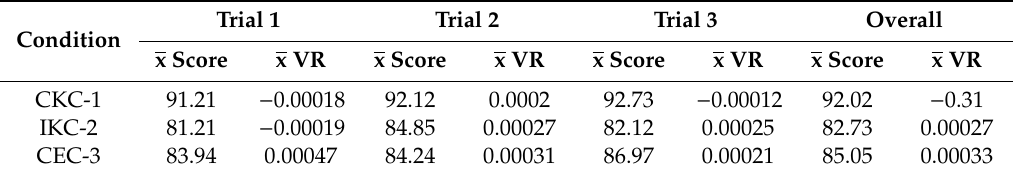
Table 1. Comparison of mean scores and mean HbO responses in each trial per task. Trial 1 Trial 2 Trial 3 Overall Condition x Score x VR x Score x VR